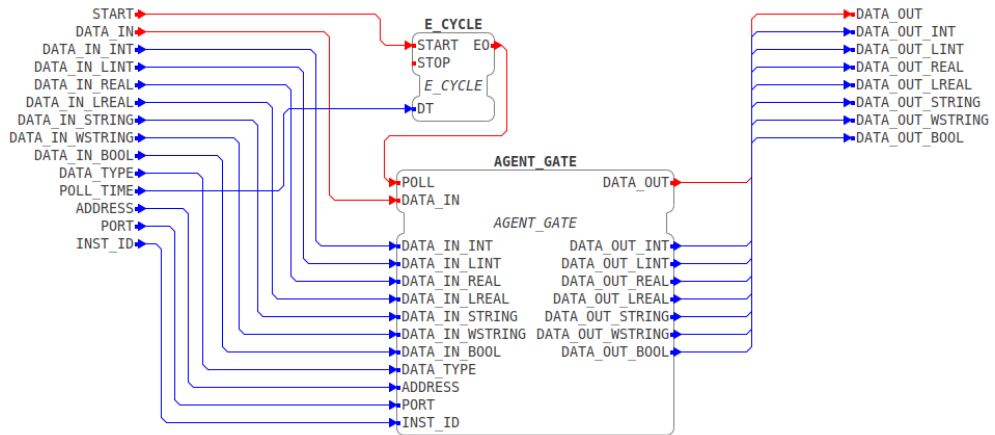
Figure 7. Diagnostic point composite function